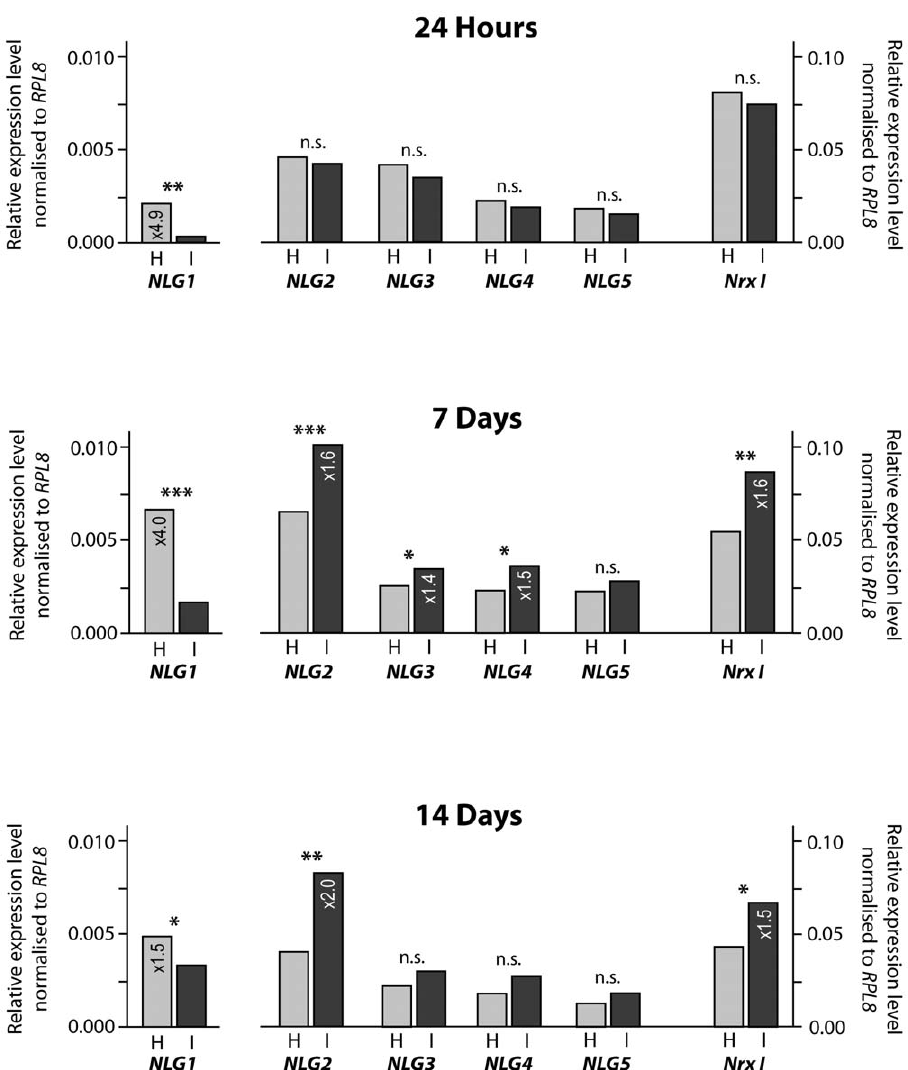
Figure 1. Effect of sensory deprivation during adult development on expression of neuroligins and neurexinI in honeybee brain. Expression of neuroligins and neurexin I in honeybee brain tissue, comparing bees that lived since emergence in a normal hive environment (H) with bees that lived since emergence in isolation in a dark incubator (I). Brain tissues were examined from bees aged 24 hours, 7 days and 14 days. NLG1: neuroligin 1, NLG2: neuroligin 2, NLG3: neuroligin 3, NLG4: neuroligin 4, NLG5: neuroligin 5, NrxI: neurexin I . Honeybee neuroligin and neurexin I expression was assessed by quantitative real time PCR amplification. The ribosomal gene RPL8 was the housekeeping gene that was used as a reference level. Methodology for data analysis and the presentation of results was taken from Pfaffl [68] and Collins et al. [66]; whereby expression levels were normalised by subtraction against the threshold cycle of the RPL8 . RPL8 expression was equivalent in hive bees and isolated bees (standard deviation 6 0.08–0.30 across all samples). Therefore, expression levels are shown relative to RPL8 . Neuroligin and neurexin expression levels shown are means of three technical replicates each. Standards errors were negligible and less than 6 1.29 for all experimental results. *** p , 0.001, ** p , 0.01, * p , 0.05, n.s. no significant difference ( t -test). Raw data from the qRT-PCR experiment are in Table S1.